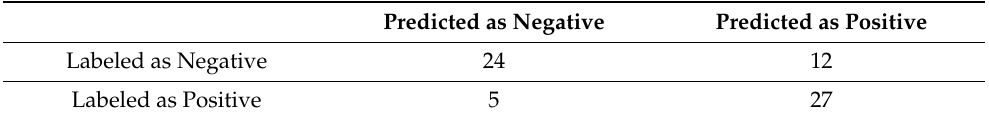
Table 4. Confusion matrix.